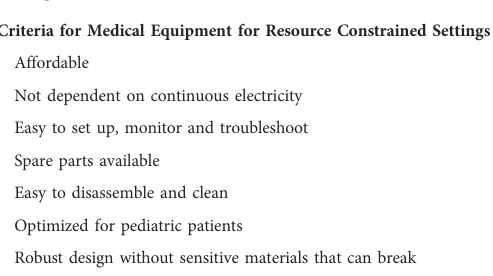
TABLE 1 Criteria for medical equipment for resource limited